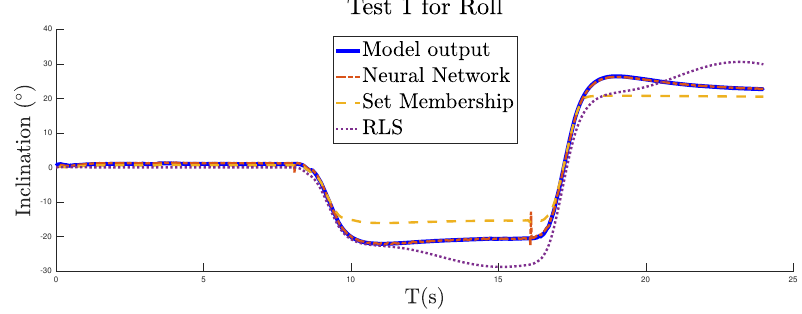
Figure 13. Test 1 results for roll.